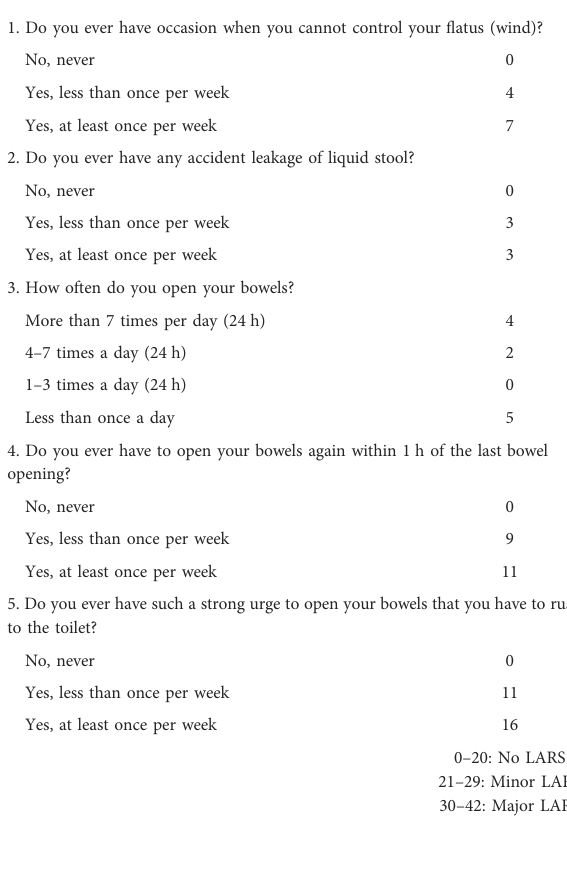
TABLE 1 LARS scoring system